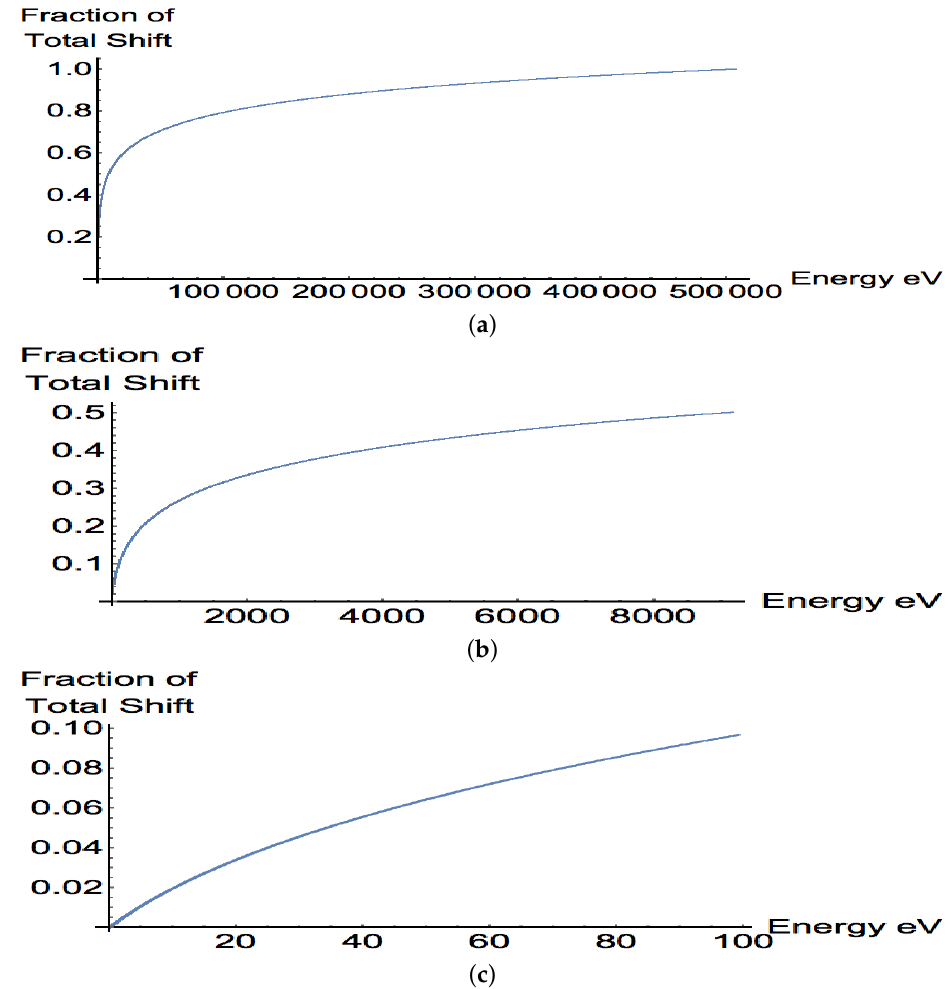
Figure 4. The ordinate is the fraction of the ground state shift ∆ E 1 due to vacuum field energies between 0 and E , plotted as a function of E . This plot is obtained by integration of the spectral density Equation (29), shown in Figure 1. The plot is linear in the ordinate and abscissa. The origin corresponds to (0,0) for all plots. ( a ): Fraction of the 1S shift due to energies from 0 to E for 0 < E < 510 keV. ( b ): Fraction of the 1S shift due to energies below E , for 0 < E < 9000 eV. ( c ): Fraction of the 1S shift due to energies from 0 to E , for 0 < E < 100 eV. Energies below 30 eV account for about 0.05 of the total shift. The variation is linear for E < 10